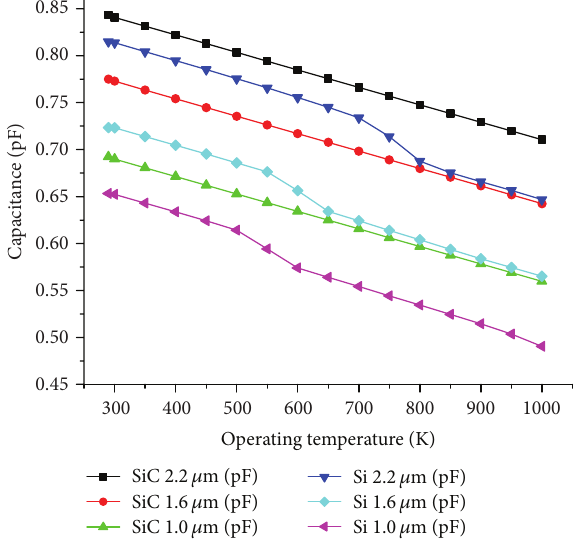
Figure13:Comparisonofcapacitanceversusoperatingtemperature of 3C-SiC and Si with differential thickness of diaphragm.